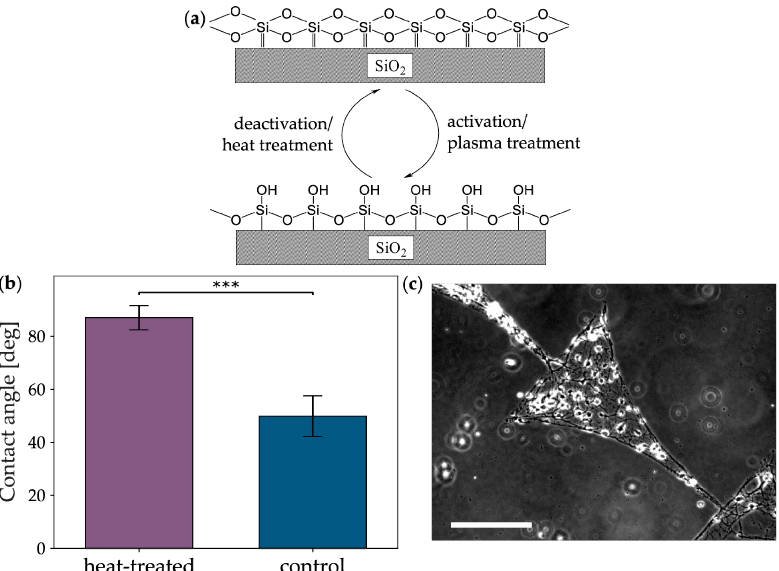
Figure 3. Theory and effects of heat-treating glass for patterned neuronal cultures. ( a ) Activation and deactivation processes on an idealized glass surface comprising only silicon oxide. By providing the activation energy of a condensation reaction between the surface hydroxyl groups with heat treatment, the glass surface should be deactivated and become less hydrophilic. ( b ) Difference of contact angle between heat-treated and untreated glass (control). Color code of the bars corresponds to Figure 1. Statistical significance was tested with the Mann-Whitney U test (p = 9.1 × 10 − 5 ; n = 10). ( c ) Phase contrast micrograph of neurons growing within pattern on heat-treated glass at DIV6. Scale bar: 100 µm.